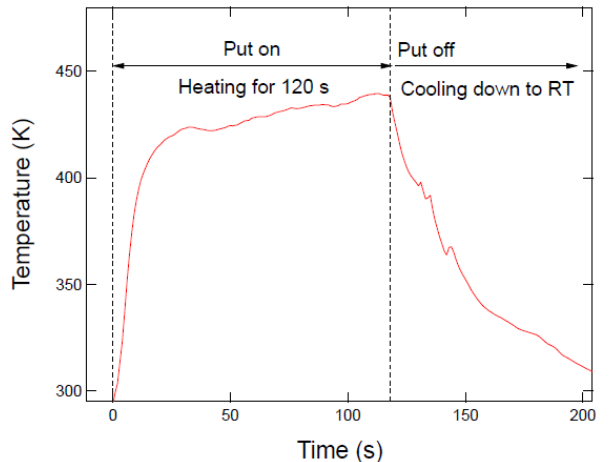
Figure 1. Temperature measured on the sample surface with chromel-alumel thermocouple during